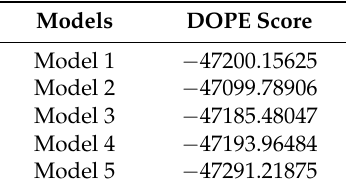
Table 1. A Table showing five successfully generated models with Modeller 9v17. The DOPE score is mainly based on probability theory and it provides information on the energy of the protein generated via Modeller 9v17.